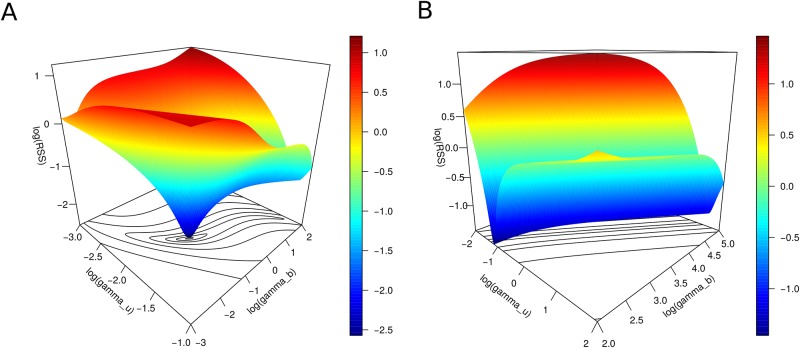
Surface plots of the RSS versus γb and γu for H1.5 data and model 9.Since the parametric space is four dimensional, these plots are projections onto the γb − γu subspace. A) RSS when the parameter region is restricted to values not greater than two orders of magnitude. B) RSS when the parameter region accepts values greater than two orders of magnitude.